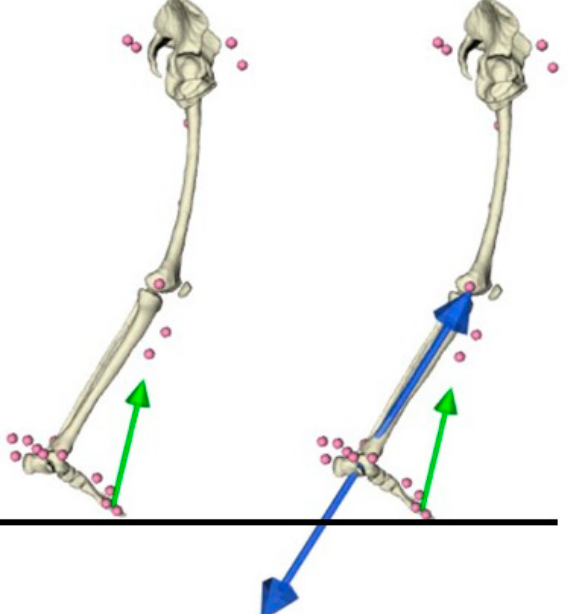
Figure 2. Visualization of difference loading acting on M1 (on the left) and M2 (on the right). Green arrow represents ground reaction force while blues arrows represent internal forces, computed as explained in Section 2.3.